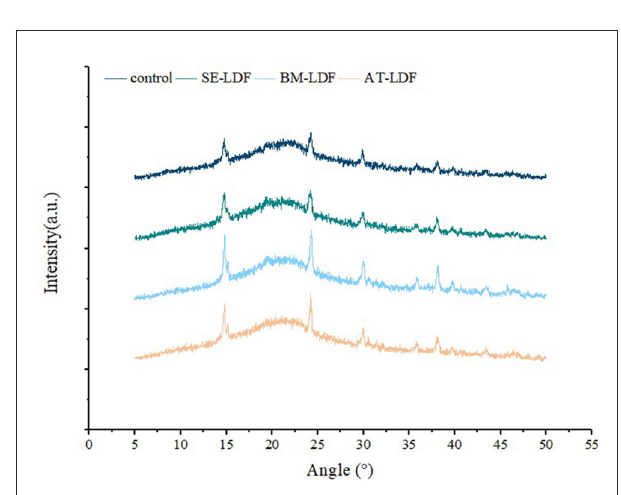
FIGURE3 X-ray diffraction of control, SE-LDF, BM-LDF, and AT-LDF. Control: lotus leaves dietary fiber. SE-LDF, shear emulsifying modified lotus leaves dietary fiber; BM-LDF, ball milling modified lotus leaves dietary fiber; AT-LDF, autoclave modified lotus leaves dietary